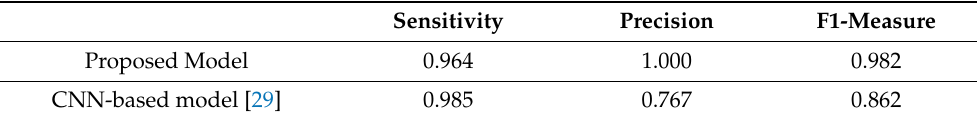
Table 3. Overall performance with CNN-based model